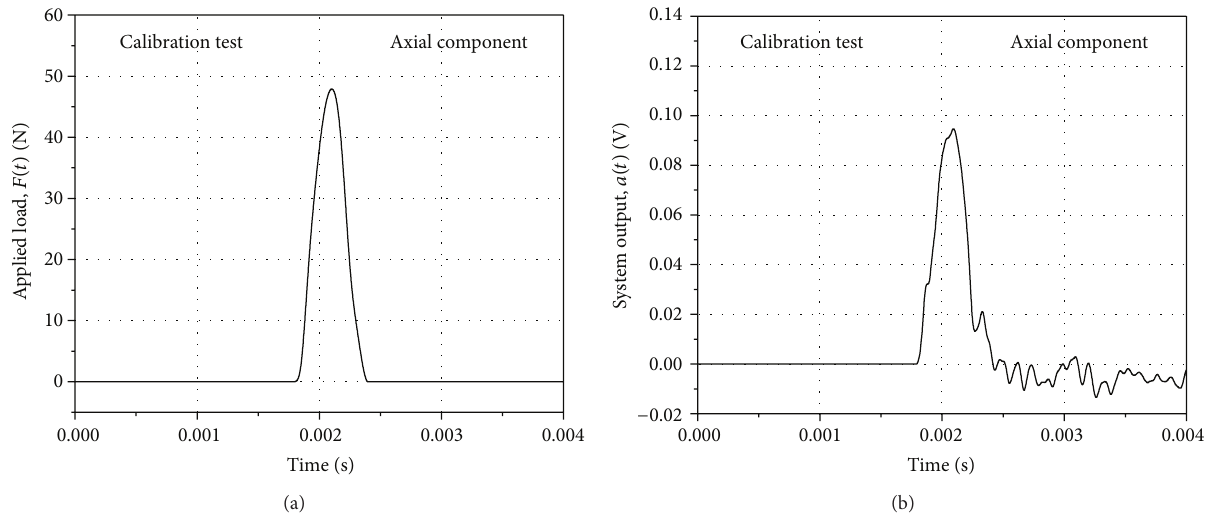
Figure 3: Calibration signals, (a) applied load and (b) system output signals for axial component.